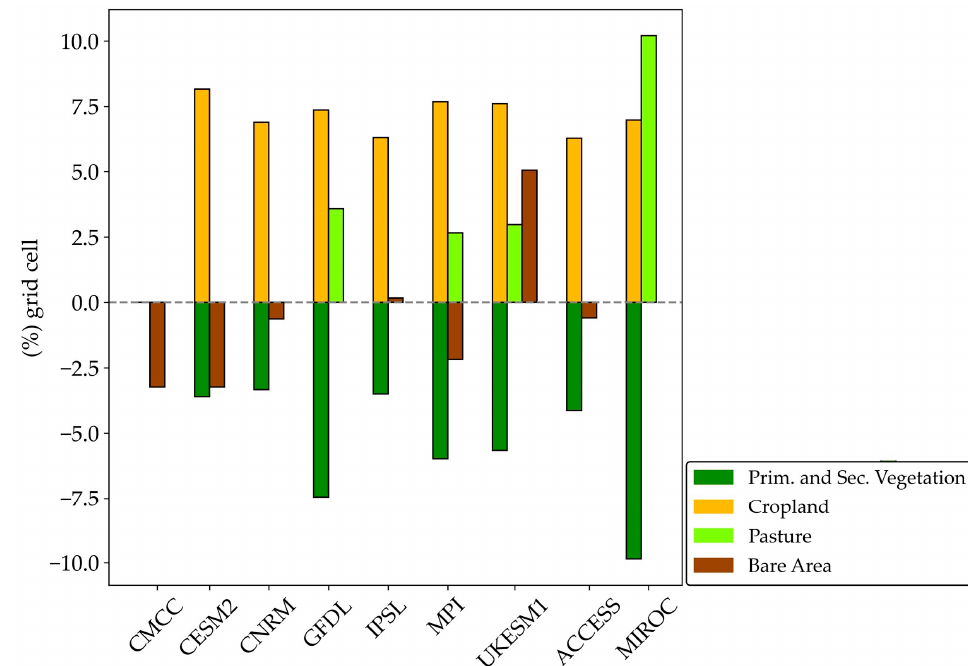
Figure 4. Quantification of LULCC ( historical—hist-noLu ). Values represent the mean annual, between 1950 to 2014, averaged over the robust grid cells for TAS. Tas and PR values are very similar. More details on bare area changes, which fluctuate between the seasons, are available in Figure S2 in the supplementary material.